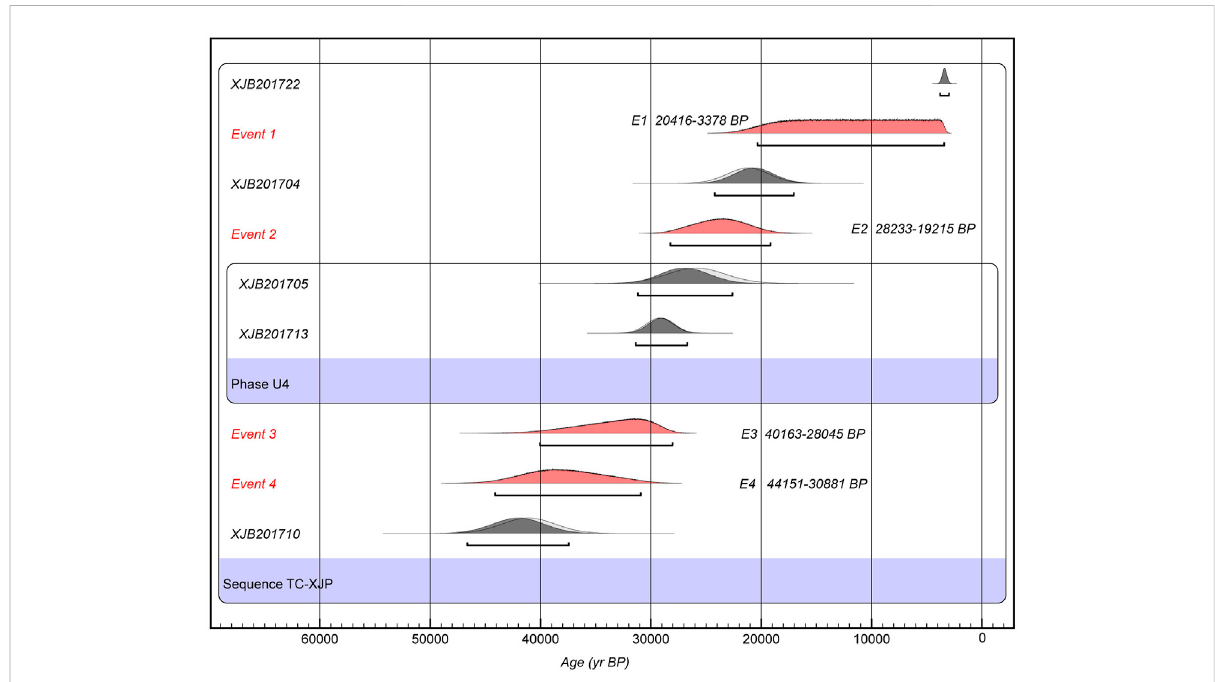
FIGURE 6 Results of OxCal analysis of luminescence dates from the Xujiabao trenching site. Un fi lled areas are prior probability distributions, and solid curves are posterior distributions after OxCal analysis. Phases are summed probability for units with multiple luminescence